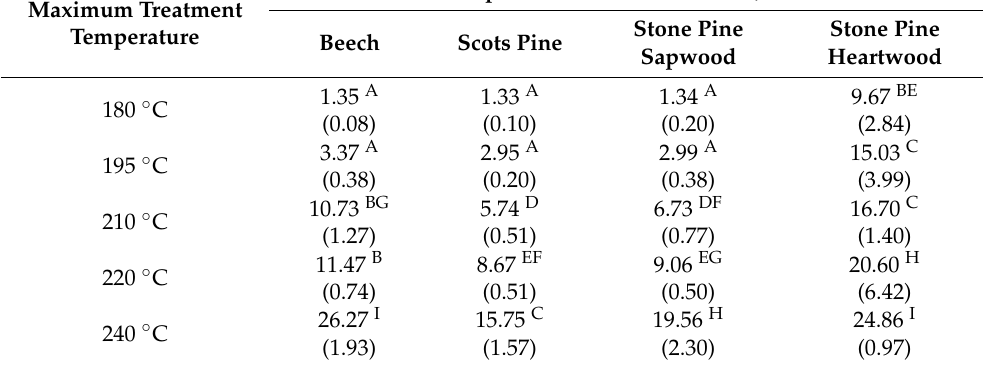
Figure 3. Correlation between thermal modification temperature and color change, considering only the L* coordinate for each species. Table 2. Wood mass loss for the different temperatures and different wood species, and Tukey’s significant difference among the mean values. Mean values that share the same letter are not statistically